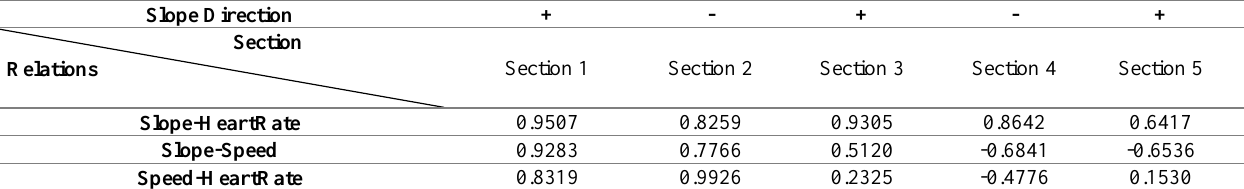
Slope Direction +